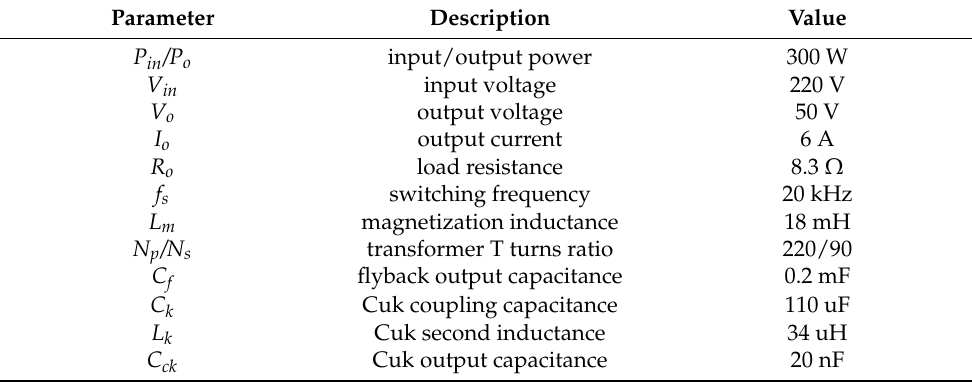
Table 1. The selected parameters for the simulation.